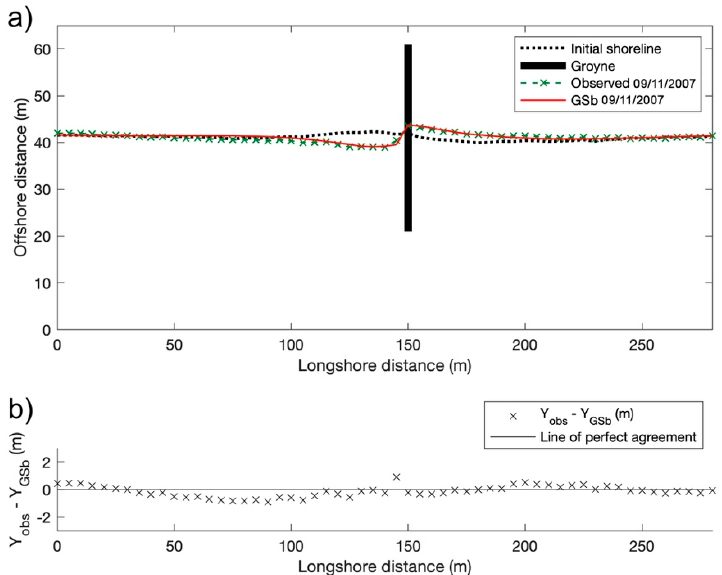
Figure 17. ( a ) Observed and calculated shorelines after 39 days from the groyne deployment. ( b ) Difference Y obs – Y GSb .